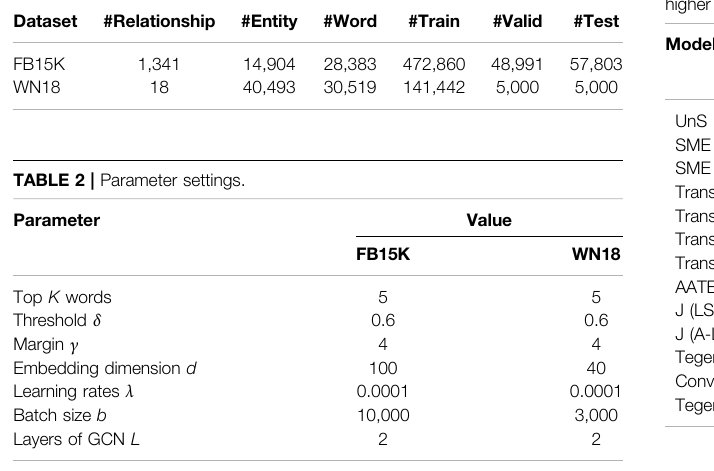
TABLE 3 | Results on link prediction. MR is the lower the better; Hits@10 is the higher the